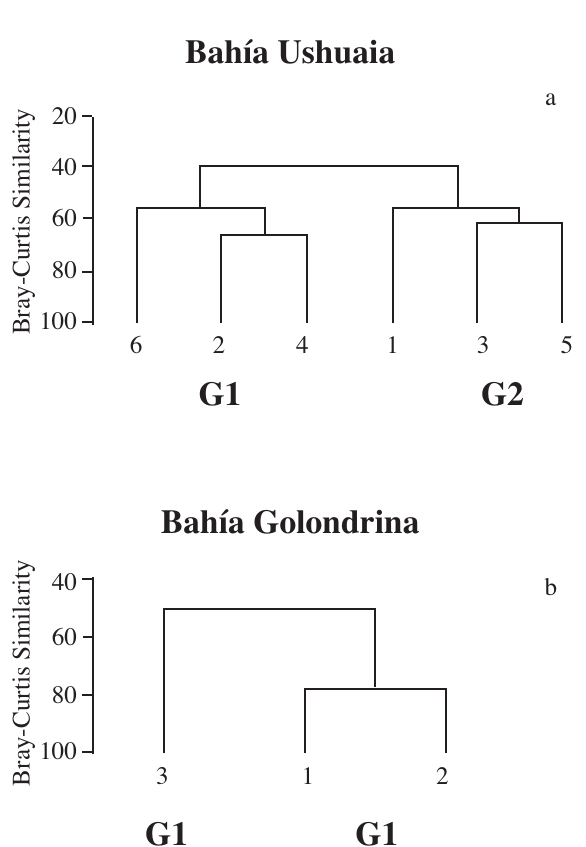
MESOZOOPLANKTON ASSEMBLAGES IN TWO BAYS OF THE BEAGLE CHANNEL 31